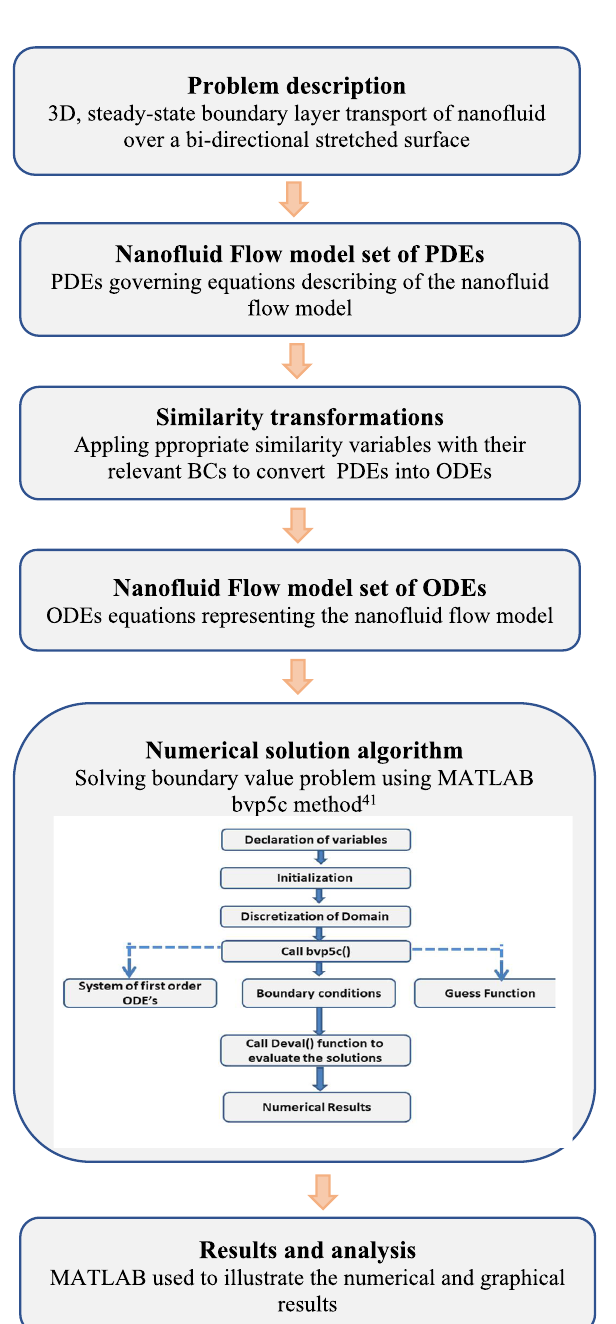
Figure 23. Boundary value problem solution method flow chart with bvp5c 41 algorithm. At first, the problem is described, then modeled by a set of nonlinear partial differential equations (PEDs) and the boundary layer approximation. The studied problem governing set of PDEs’ were non dimensionalized using similarity transformation non-dimensional variables and applied relevant boundary conditions. The obtained set of coupled linear ordinary differential equations (ODEs) representing the problem is solved numerically using the built-in bvp5c technique in computational software MATLAB. Detailed info on the algorithm used at the bvp5c function is described in the appendix on Owhaib et al. 41 The numerical and graphical results are illustrated using MATLAB. A discussion on the impact of prevailing parameters’ is